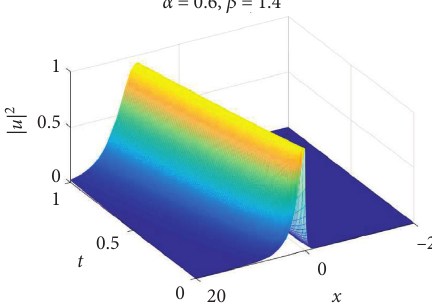
Figure 1: The trace of the solution to | u | 2 of FCNLSE (32) with α � 0 . 6 and β � 1 . 4.